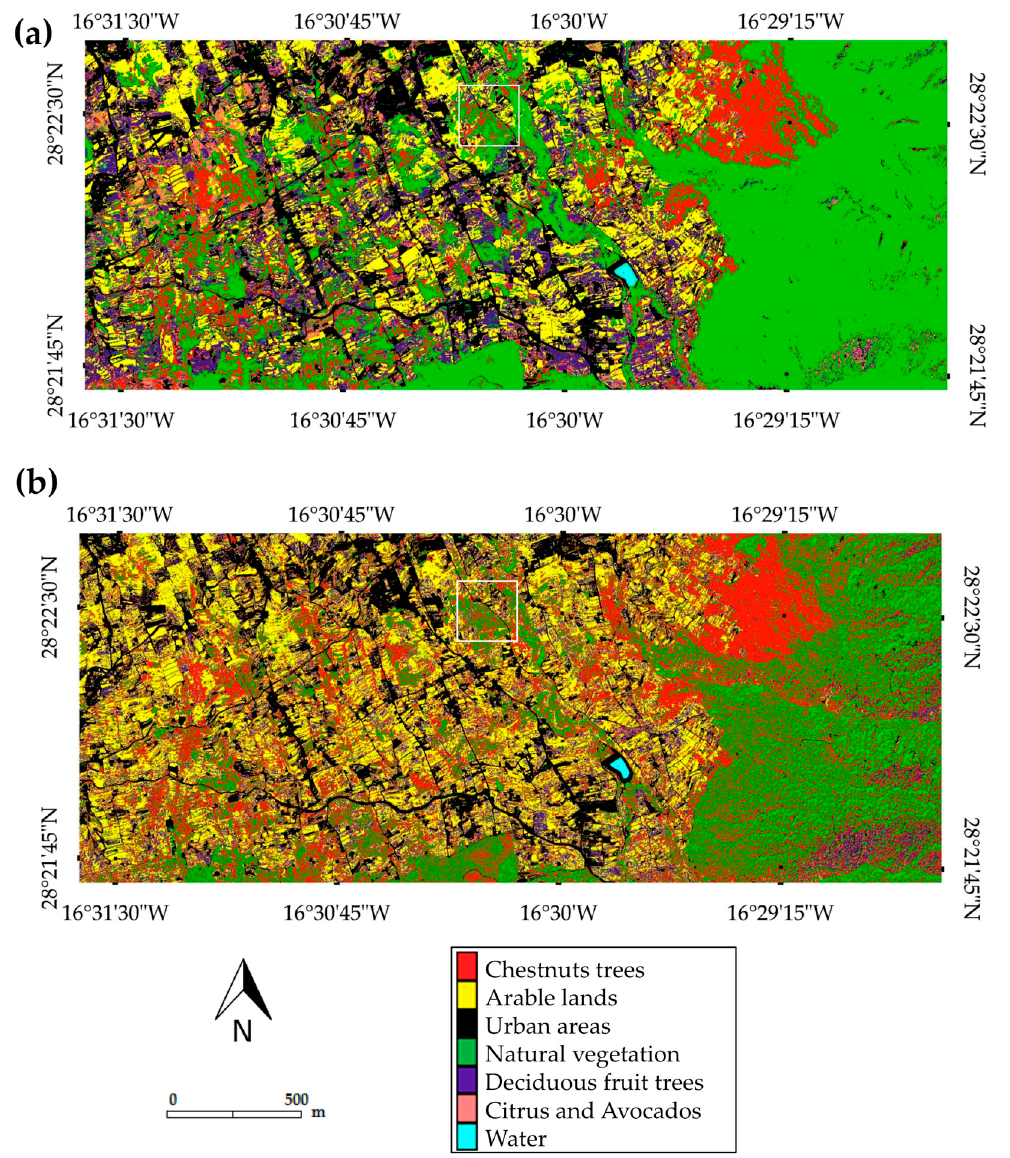
Figure 6. ( a ) Bi-temporal_EMP classified with RF. ( b ) May without EMP image classified with RF. A subset (28°22'35.75"N, 16°30'22.21"W; 28°22'25.49"N, 16°30'10.32"W) indicated by the white square is shown in Figure 7.